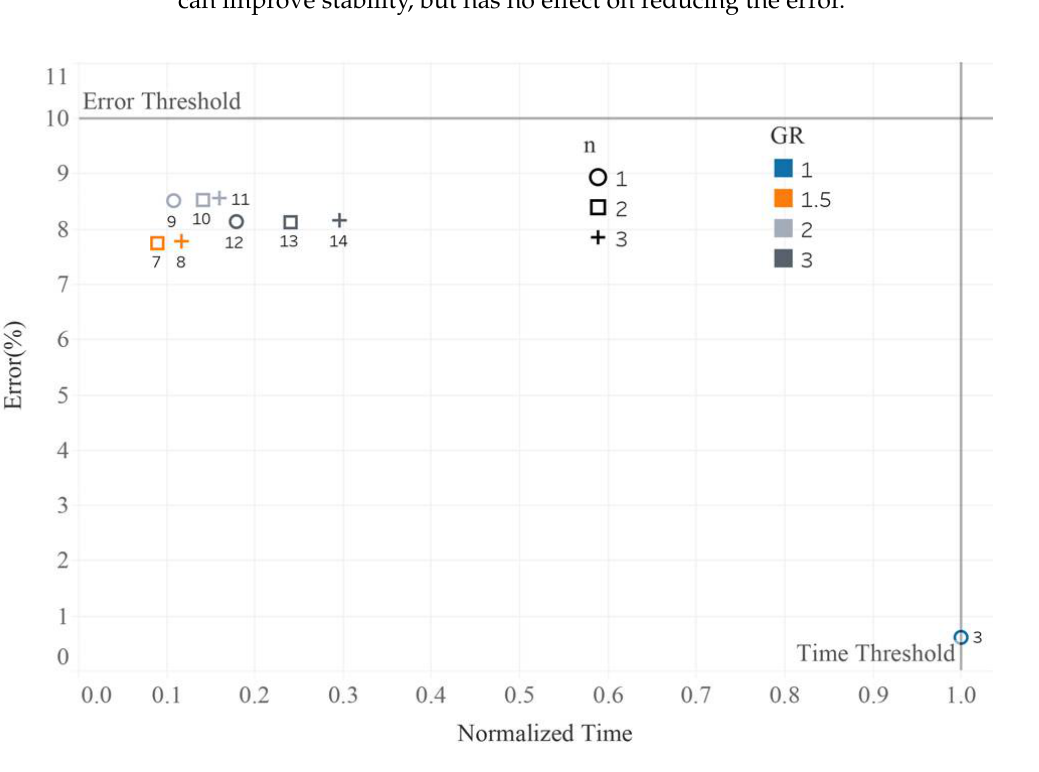
Figure 7. Effect of GR and n on computational time and error for Pr = 100. Compared to the conventional SRT method, the MGLB method offers better stability and computational time with reasonable